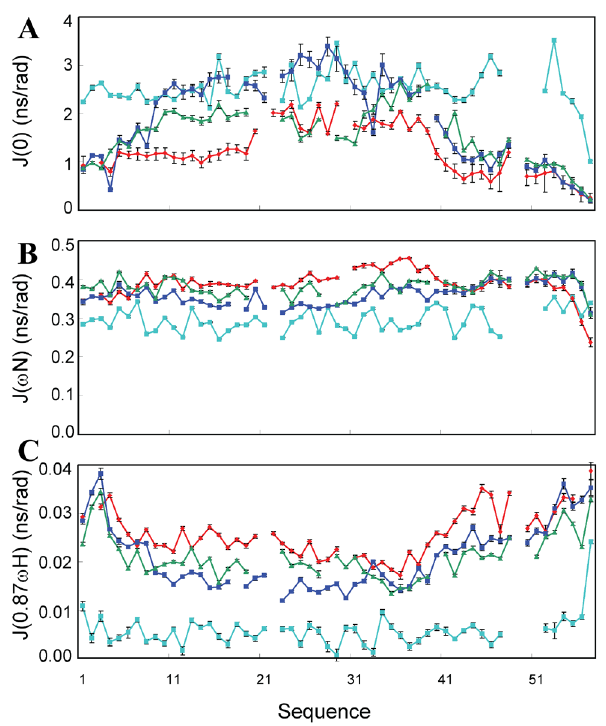
Figure 10. Reduced spectral density function analysis. Spectral densities of V22-SH3 solubilized in unsalted water at pH 4.0 (red); wild-type at pH 6.5 (cyan); wild-type at pH 2.0 (blue) and 4Ala mutant at pH 6.5 (green), calculated from the 15 N backbone relaxation data measured at 800 MHz. ( A ) J(0), ( B ) J( v N), and ( C ) J(0.87 v